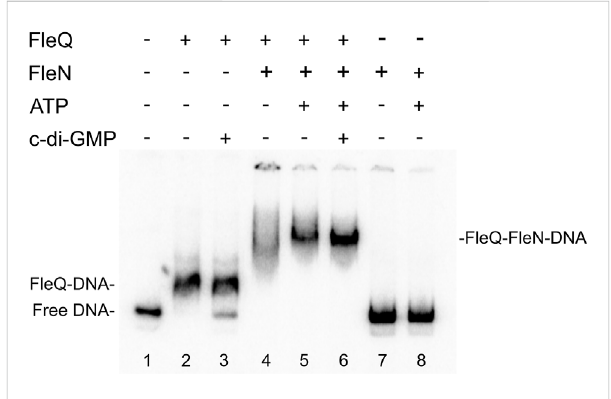
FIGURE 3 In vitro binding of the FleQ-FleN complex to the wss promoter region. Binding reactions were carried out as described in Materials and Methods with 1 nM of labelled wssA1-2 fragment in the absence (-) and in the presence of 1 μ M FleQ, 1 μ M FleN, 0.5 mM of ATP and 0.5 mM c-di-GMP. Putative shifted FleQ-DNA, and FleQ-FleN- DNA complexes are